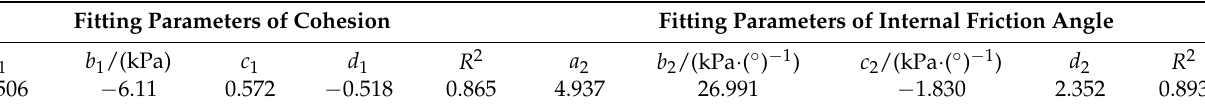
Table 3. Fitting results of sandy-gravel